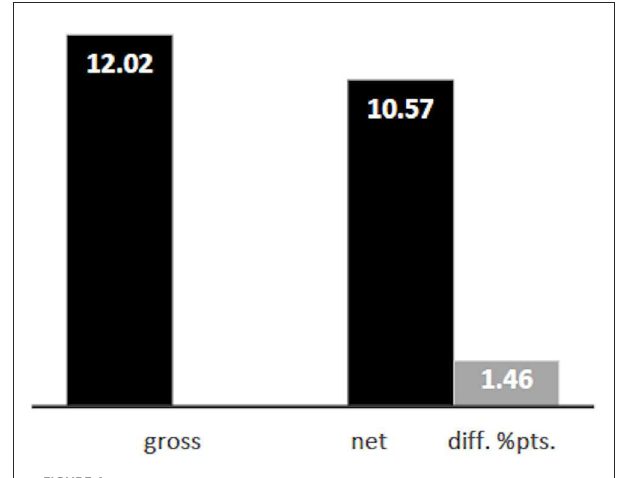
FIGURE4 Gross and net level of segregation of persons with migration background,